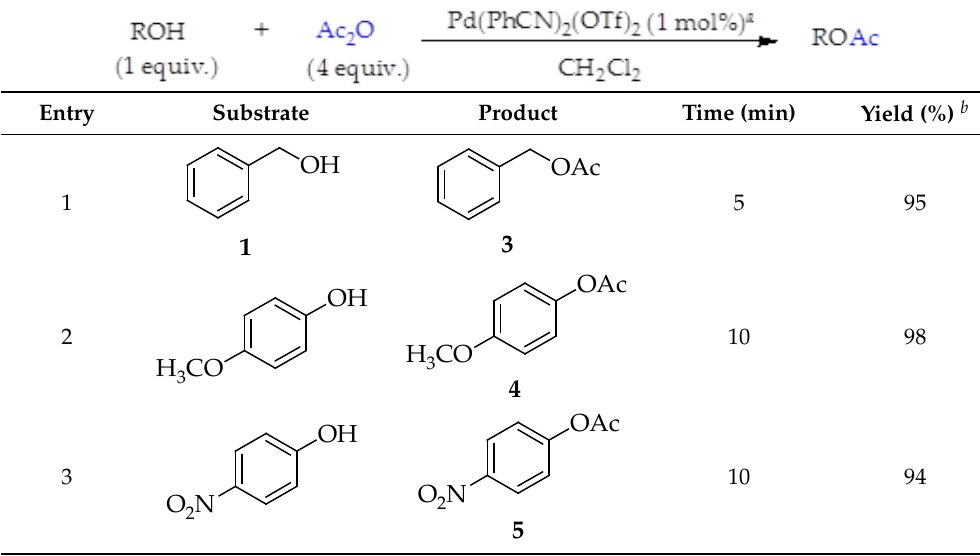
Table 3. Acetylation of alcohols with acetic anhydride catalyzed by Pd(PhCN) 2 (OTf) 2 .